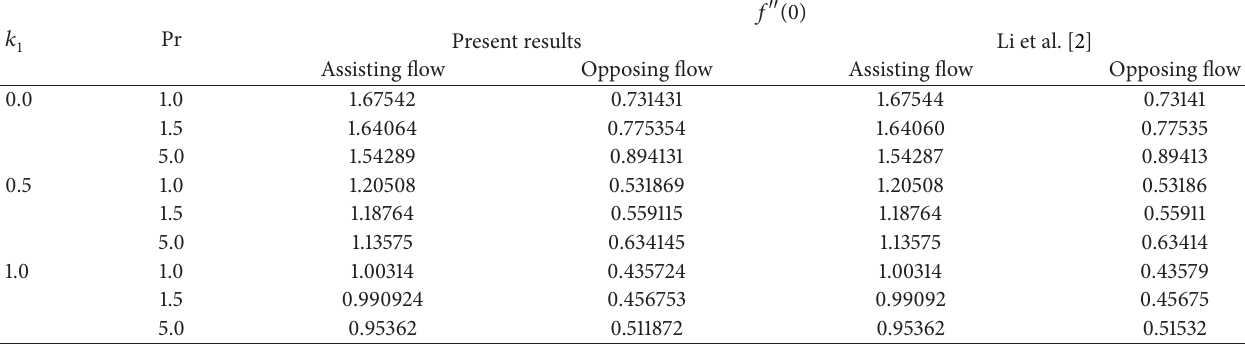
Table 3: Comparison of 𝑓 󸀠󸀠 (0) for various values of 𝑘 1 and Pr when 𝑚 = 1.0 and 𝜆 𝑇 = 1.0